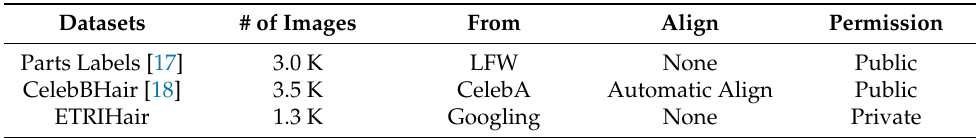
Table 3. Our training datasets for hair segmentation. Datasets # of Images From